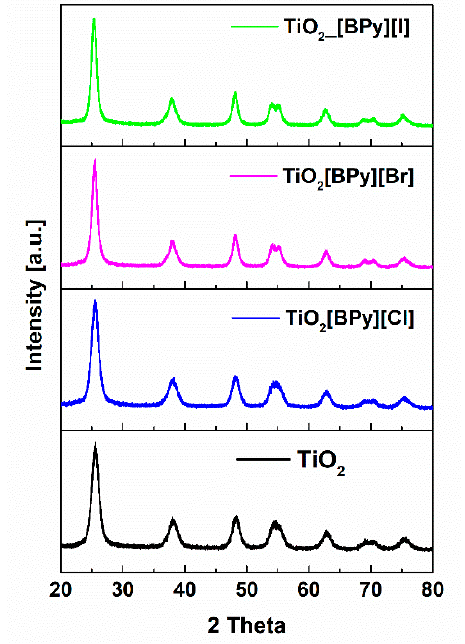
Figure 2. The X-ray diffraction patterns for the IL-TiO 2 and pristine TiO 2 samples.